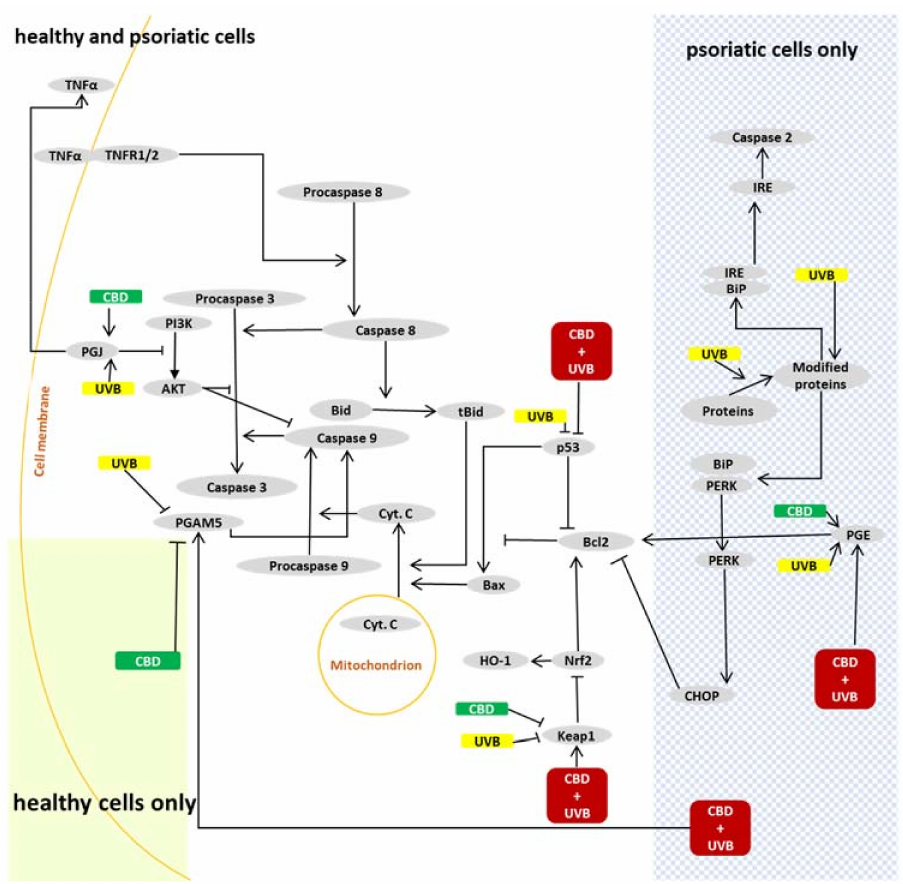
Figure 7. The most important pathways involved in modulation of apoptosis by CBD, UVB or CBD+UVB in psoriatic and healthy